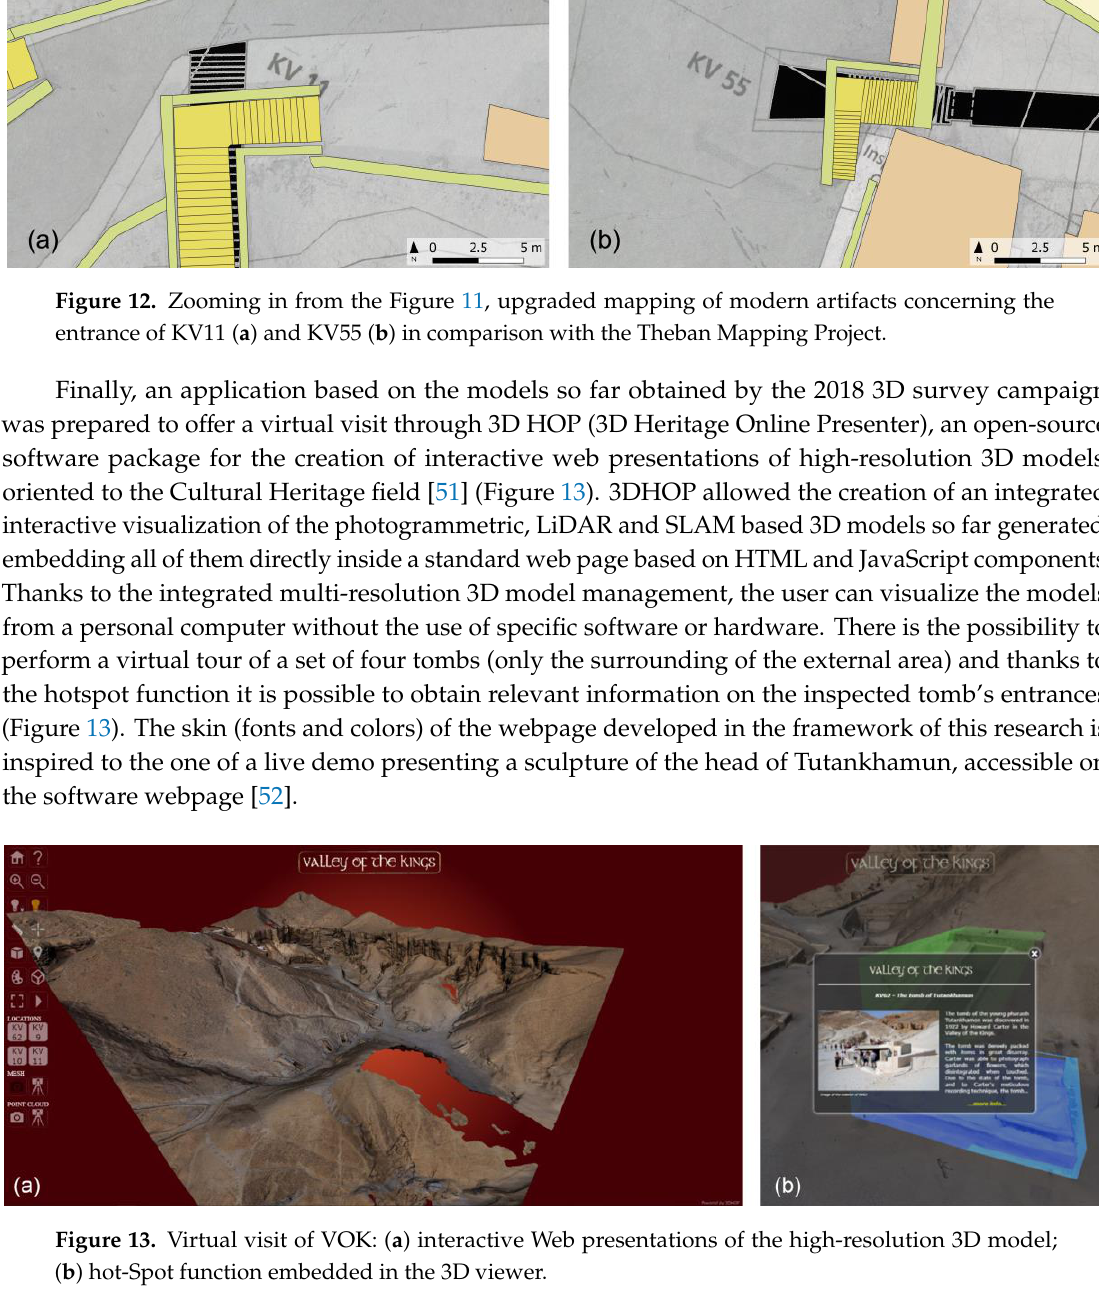
Figure 11. Different survey products and underground tombs derived from the Theban mapping project sheets integrated into the Geographic Information System (GIS) environment. ( a ) Sheet 5/70, KV (3/4) extracted from the Atlas of the TMP, page 21, with superimposed the new global grid (50 m interval), Plan 1:400, Contour interval 2 m; ( b ) the corresponding area with the up-to-date